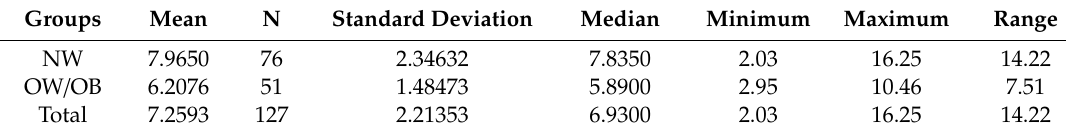
Table 2. Descriptive analysis of AMY1 copy number variations (CNV) in study population.